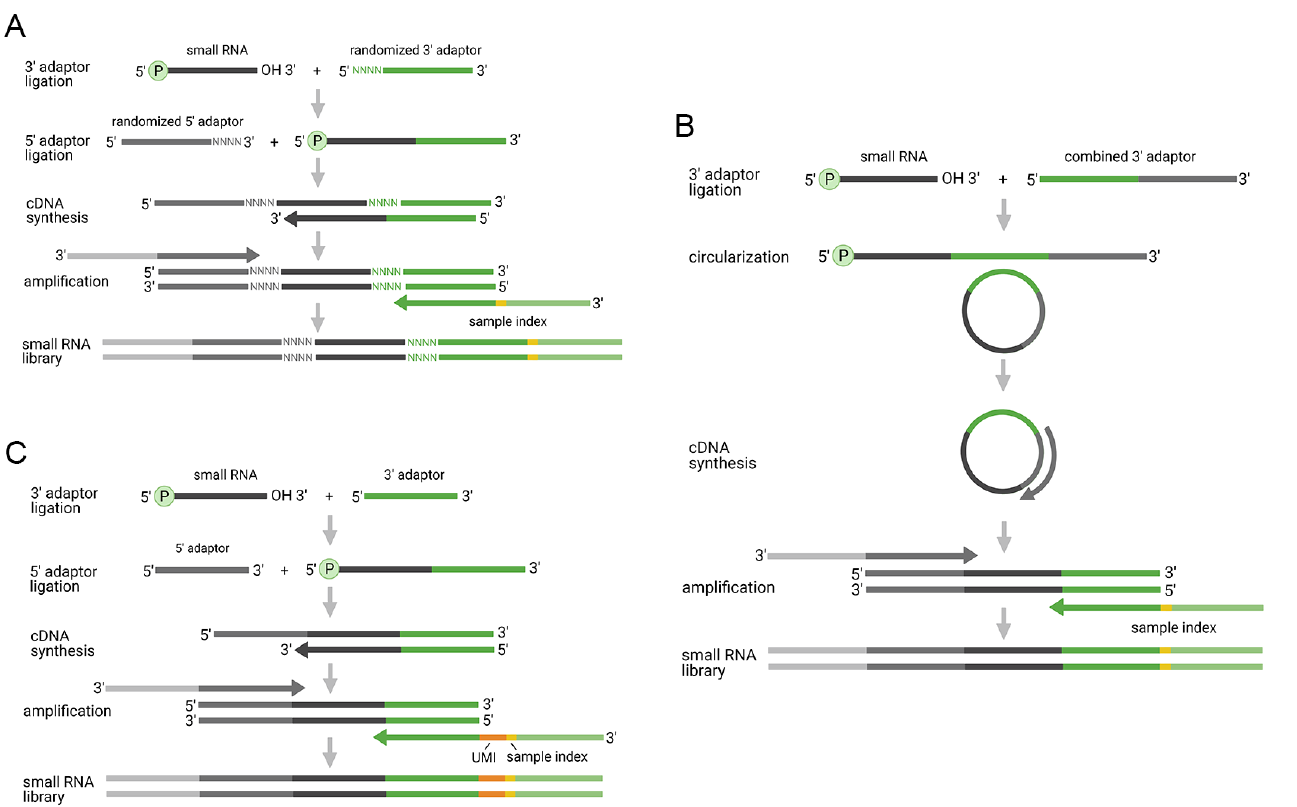
Figure 2. Improved two-adaptor ligation-based methods for small RNA-seq analysis. The reduction of ligation or PCR bias is achieved by: ( A ) randomized adaptors; ( B ) single adaptor-ligation and circularization; and ( C )